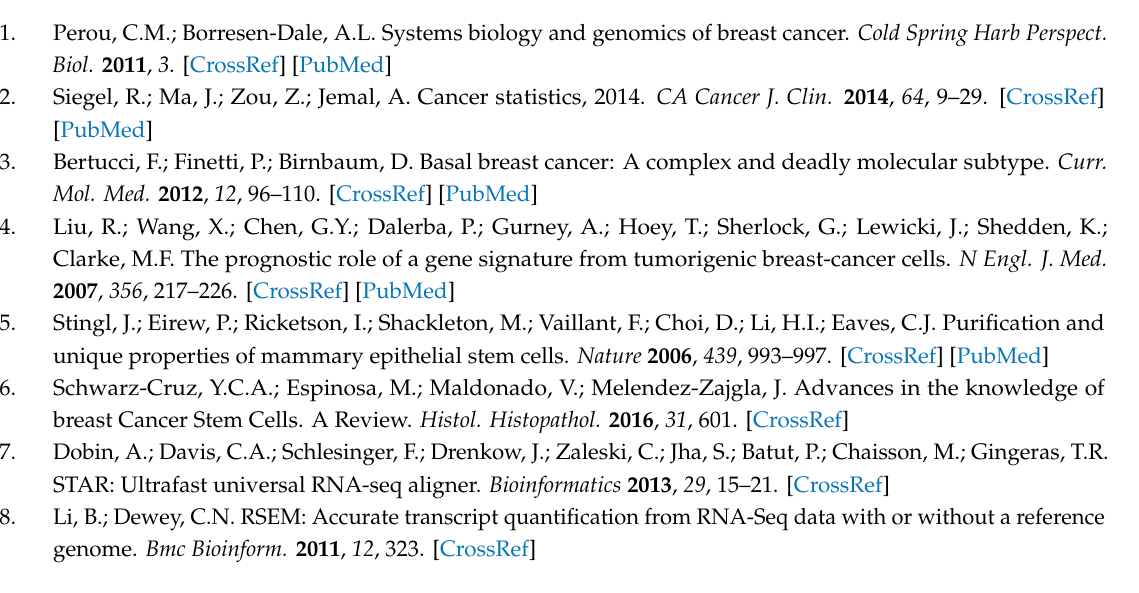
Figure S1: Enriched signaling cascade of gene isoforms upregulated in Breast Cancer Stem Cells. Figure S2: Kaplan–Meier survival plot for relapse-free and overall survival in breast cancer patients’ molecular subtypes. Figure S3: Kaplan–Meier survival plot for relapse-free and overall survival in breast cancer patients. Table S1: Primers used in the study. Supplementary Data: MDA-MB-468 mRNA Di ff erential Expression with an FDR <